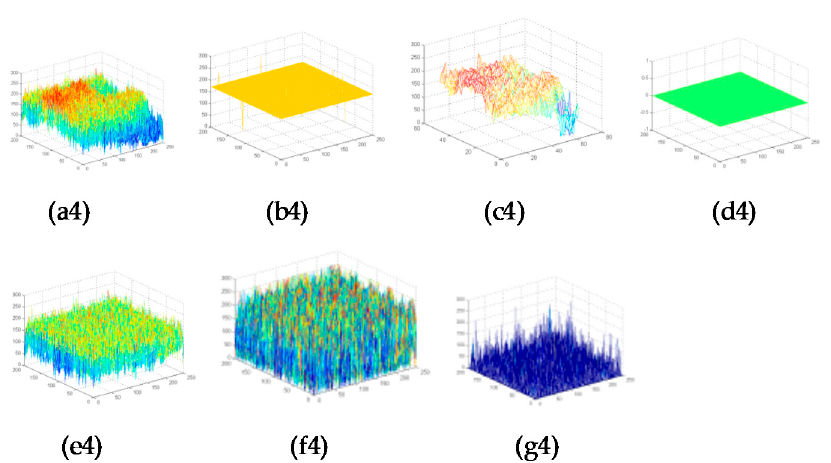
Figure 9. 3D gray maps of four representative scenes and corresponding results. ( a1 – a4 ) Original image; ( b1 – b4 ) IPI; ( c1 – c4 ) ILCM; ( d1 – d4 ) NRAM; ( e1 – e4 ) WTRPCA; ( f1 – f4 ) Tophat; ( g1 – g4 ) OURS.